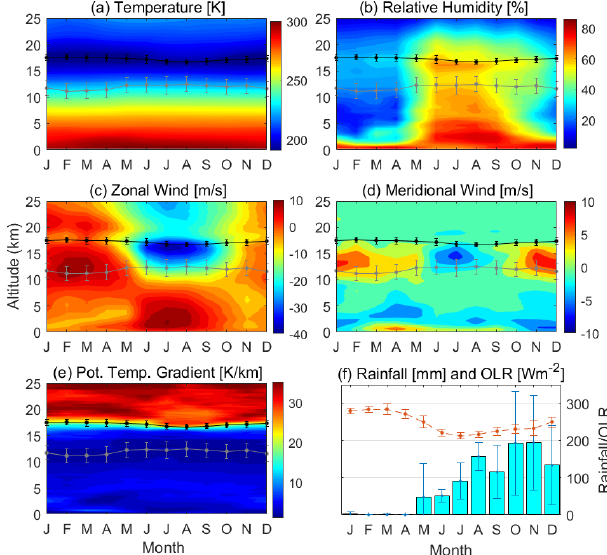
Figure 1. Time–height sections of the composite monthly mean (a) temperature, (b) relative humidity, (c) zonal wind, (d) merid- ional wind, and (e) potential temperature gradient superimposed with the monthly mean and standard deviation of the CPT (black line) and COT (gray line) heights. The monthly means of the (f) rainfall (cyan) and outgoing longwave radiation (OLR) (ma- genta) with their standard deviations are also